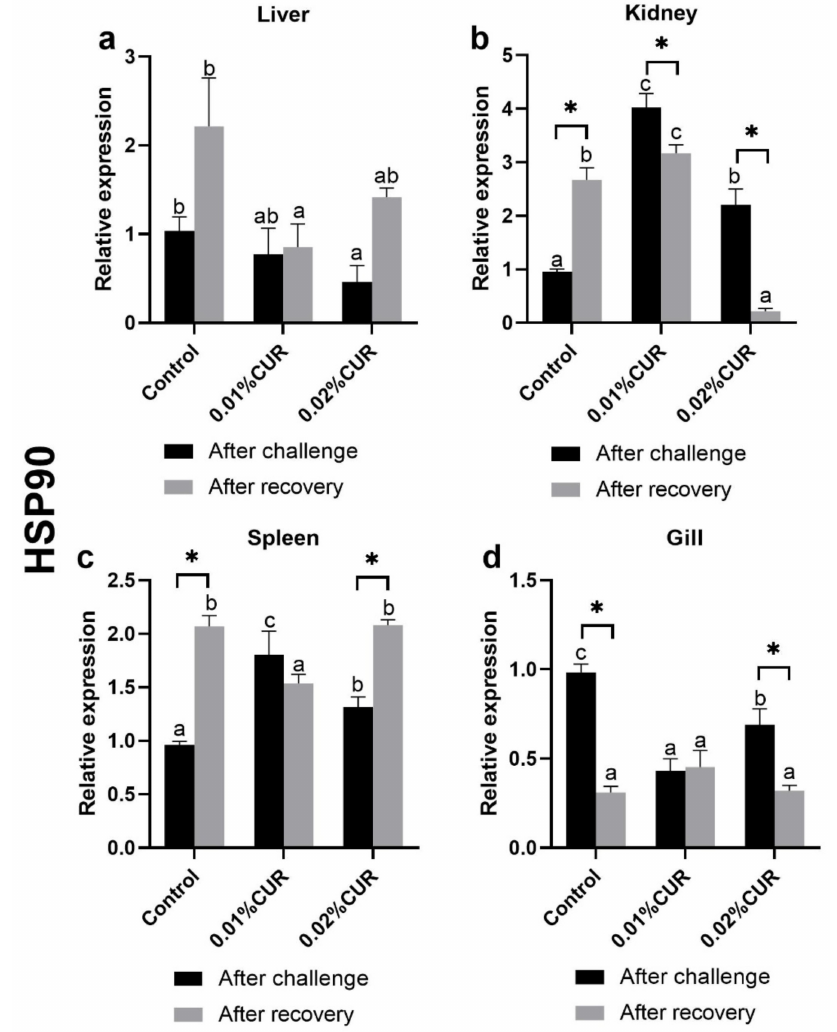
Figure 7. The relative expression of heat shock protein (HSP90) genes in ( a ) liver, ( b ) kidney, ( c ) spleen and ( d ) gill tissue of greater amberjack fed with dietary curcumin supplementation. (Different letters above bars and asterisk sign (*) indicate significant differences at the 0.05